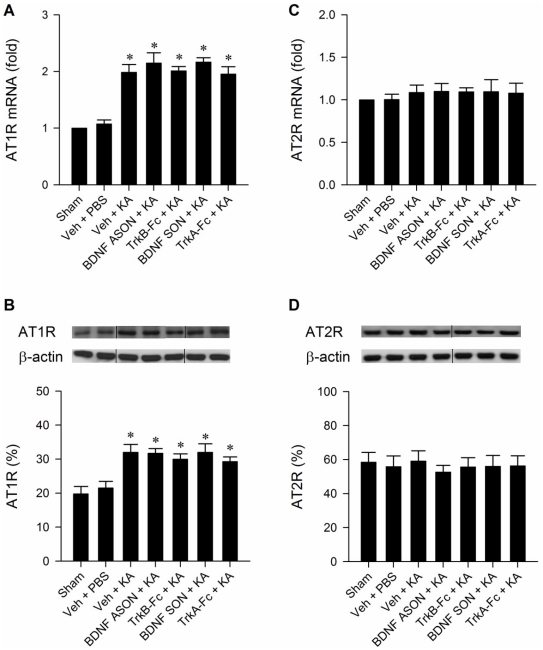
BDNF and TrkB do not interact with AT1R in RVLM.Illustrative gels or summary of fold changes in angiotensin receptor subtype 1 (AT1R) or subtype 2 (AT2R) mRNA (A,C) against sham-control detected by real-time PCR (A,C) or AT1R or AT2R protein detected by Western blot analysis (B,D) in samples collected from bilateral RVLM 180 min after microinjection of KA (0.5 nmol) or PBS into the left hippocampal CA3 subfield of animals that received pretreatment by application into the bilateral RVLM of distilled water or 0.1 M PBS (Veh), BDNF ASON or SON (100 pmol), TrkB-Fc (1.5 pmol) or TrkA-Fc (1.5 pmol). Values are mean ± SEM of triplicate analyses on individual samples obtained from 5–6 animals per experimental group. *P<0.05 versus sham-control or PBS group in the post hoc Scheffé multiple-range test. Note that in (B,D), dividing lines are placed on the gel images to denote groupings of images from different parts of the same gel or from different gels.